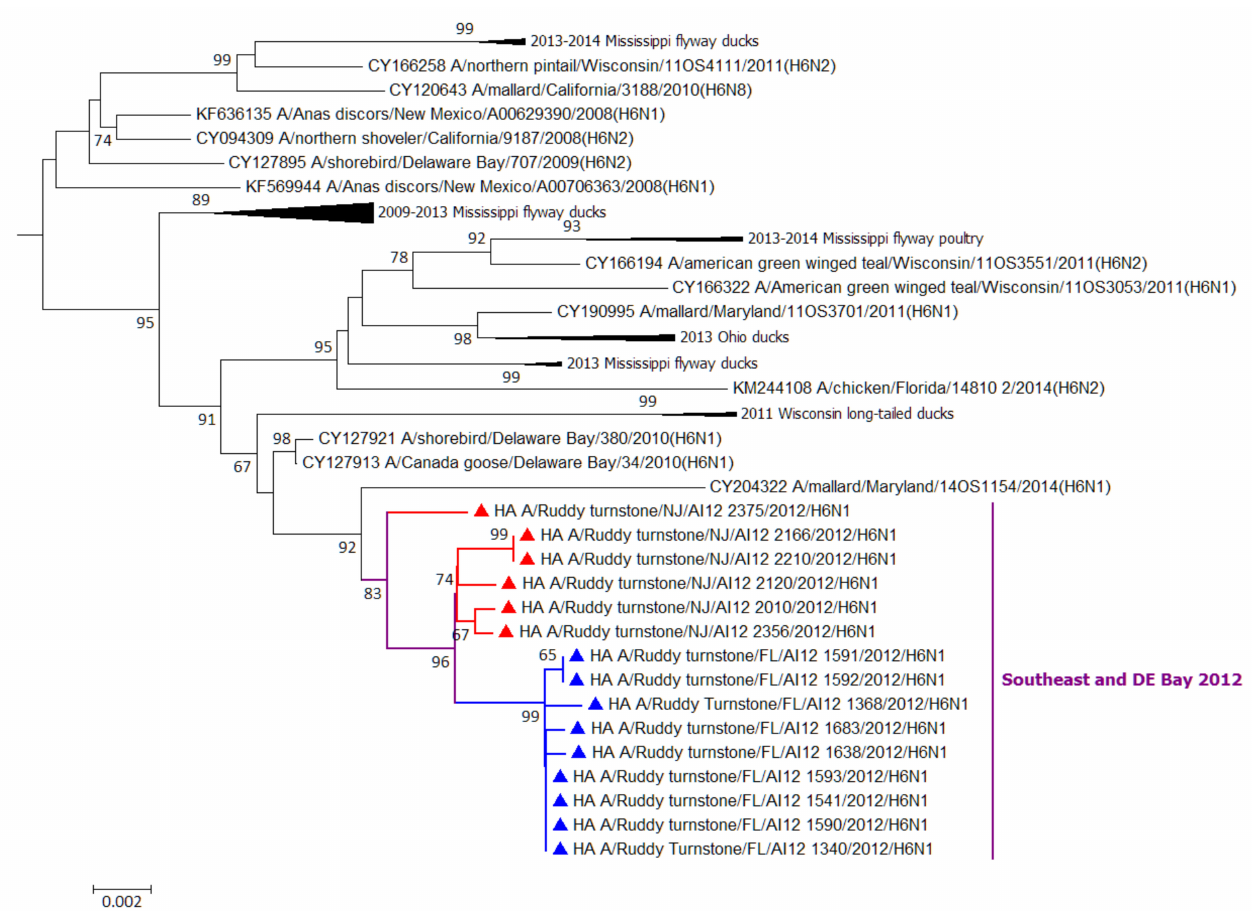
Figure 2. Maximum-likelihood (ML) phylogenetic sub-tree for hemagglutinin HA6 gene segments derived from influenza A viruses isolated from wild and domestic birds in North and South America (excluding Alaska), without date restriction. Nodes for HA6 segments identified in this study are colored in red (Delaware Bay) or blue (southeast) triangles. Bootstrap values lower than 65 are omitted. Branch lengths are measured in the number of nucleotide substitutions per